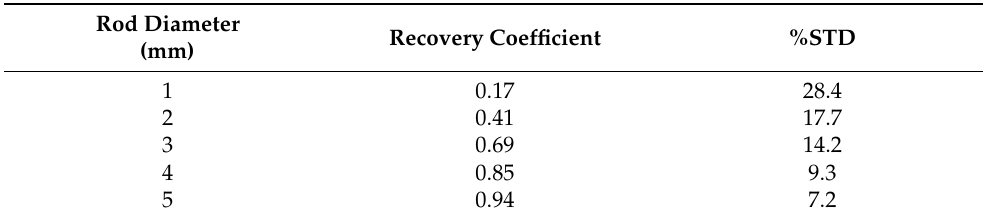
Table 3. The calculated recovery coefficients for five different sizes if rods and their percentage standard